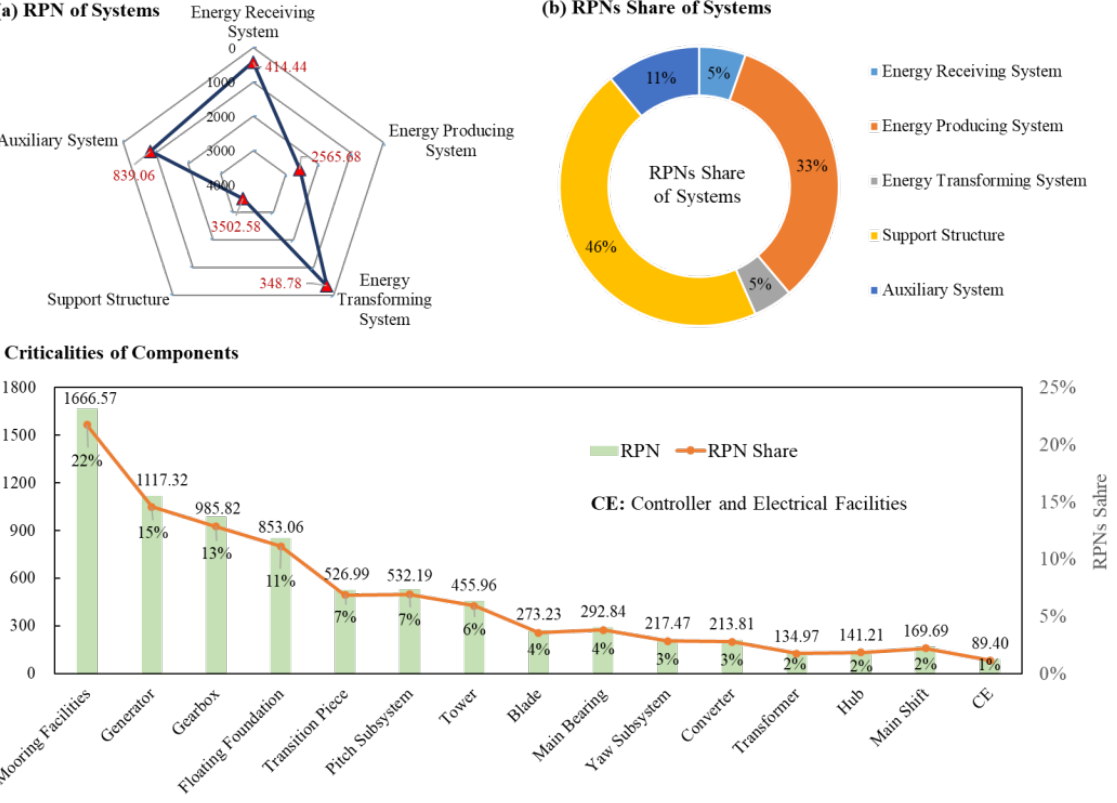
Figure 2. Failure analysis of systems and components of floating offshore wind turbines/( a ) RPNs of systems; ( b ) RPNs shares of systems; ( c ) RPNs and their corresponding shares of components.